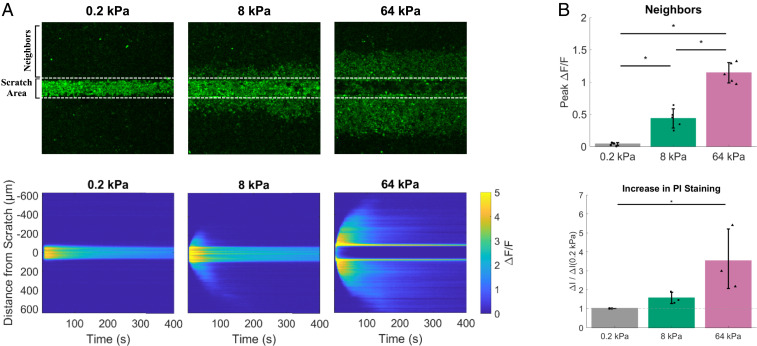
Stiffening of the extracellular microenvironment leads to cell damage-dependent intercellular signaling by mechanical stimulation. (A, Top) Scratch assays were applied to human breast epithelial cells (MCF10A) plated on soft (0.2 kPa), moderately stiff (8 kPa), and stiff (64 kPa) dishes. (A, Bottom) Kymographs show total scratch-induced calcium signaling (ΔF/F) signaling across the cell monolayer (0 ± 600 µm) as well as within the scratch area (0 ± 125 µm) during the experimental time course. Intercellular signaling to neighboring cells (neighbors) away from the scratch area (dotted lines) was only present in cells scratched on stiff (8 to 64 kPa) dishes and did not occur on soft dishes (0.2 kPa). (B, Top) Bar graph (Neighbors) shows quantification (peak ΔF/F) of signaling to neighbors from cells scratched on soft (0.2 kPa), moderately stiff (8 kPa), and stiff (64 kPa) dishes. Propidium iodide (PI) was used to measure cellular damage in scratched cells. (B, Bottom) Bar graph (increase in PI staining) shows quantification of changes in PI staining before vs. after scratch (ΔI/ΔI[0.2 kPa]). PI-positive cells were only present in cells scratched on stiff (8- to 64-kPa) dishes and were only present within the scratch area. Scratch on cells plated in soft environments (0.2 kPa) did not result in cellular damage as measured by PI. The collective data indicate that when cells plated on soft (0.2-kPa) substrates are stimulated in a manner that resembles a scratch wound assay, the stimulus does not create a scratch/gap area or induce cell damage-dependent signaling to neighboring cells, therefore resulting in a damage-independent calcium response. Data are presented as mean ± SD. The asterisk (*) indicates significance, which was set to P < 0.05 via one-way ANOVA with a post hoc Tukey’s honest difference criterion. For PI staining (ΔI/ΔI[0.2 kPa]), data represent n = 3 in total from three independent experiments for each group. For calcium signaling (ΔF/F), data represent n = 5 in total from five independent experiments for each group.